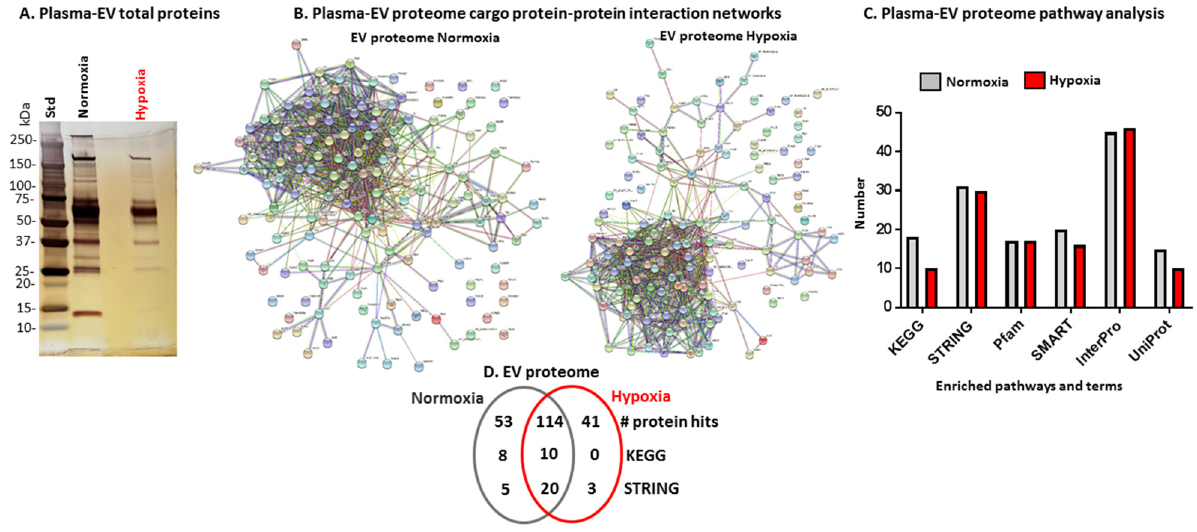
Figure 2. Total proteomic cargo of plasma EVs from normoxia- and hypoxia-treated naked mole- rats. ( A ) SilverGel showing total protein EV cargo that was then subjected to LC-MS/MS analysis. ( B ) Protein interaction networks for the plasma EV proteome of normoxia- and hypoxia-treated naked mole-rats. ( C ) Histogram showing the number of pathway analysis terms associated with the proteome of EVs from normoxia- and hypoxia-treated animals ( n = 5 animals per group). ( D ) Venn diagram showing unique and shared protein hits, and KEGG and STRING pathways between EV proteomes of the normoxia and hypoxia groups ( n = 5 animals per group). Table 1. Total proteome of plasma EVs under normoxia and hypoxia conditions. Shared hits are listed at the beginning of the table, blue highlighted rows are hits identified only in normoxia EVs, and pink highlighted rows are hits only identified in hypoxia.